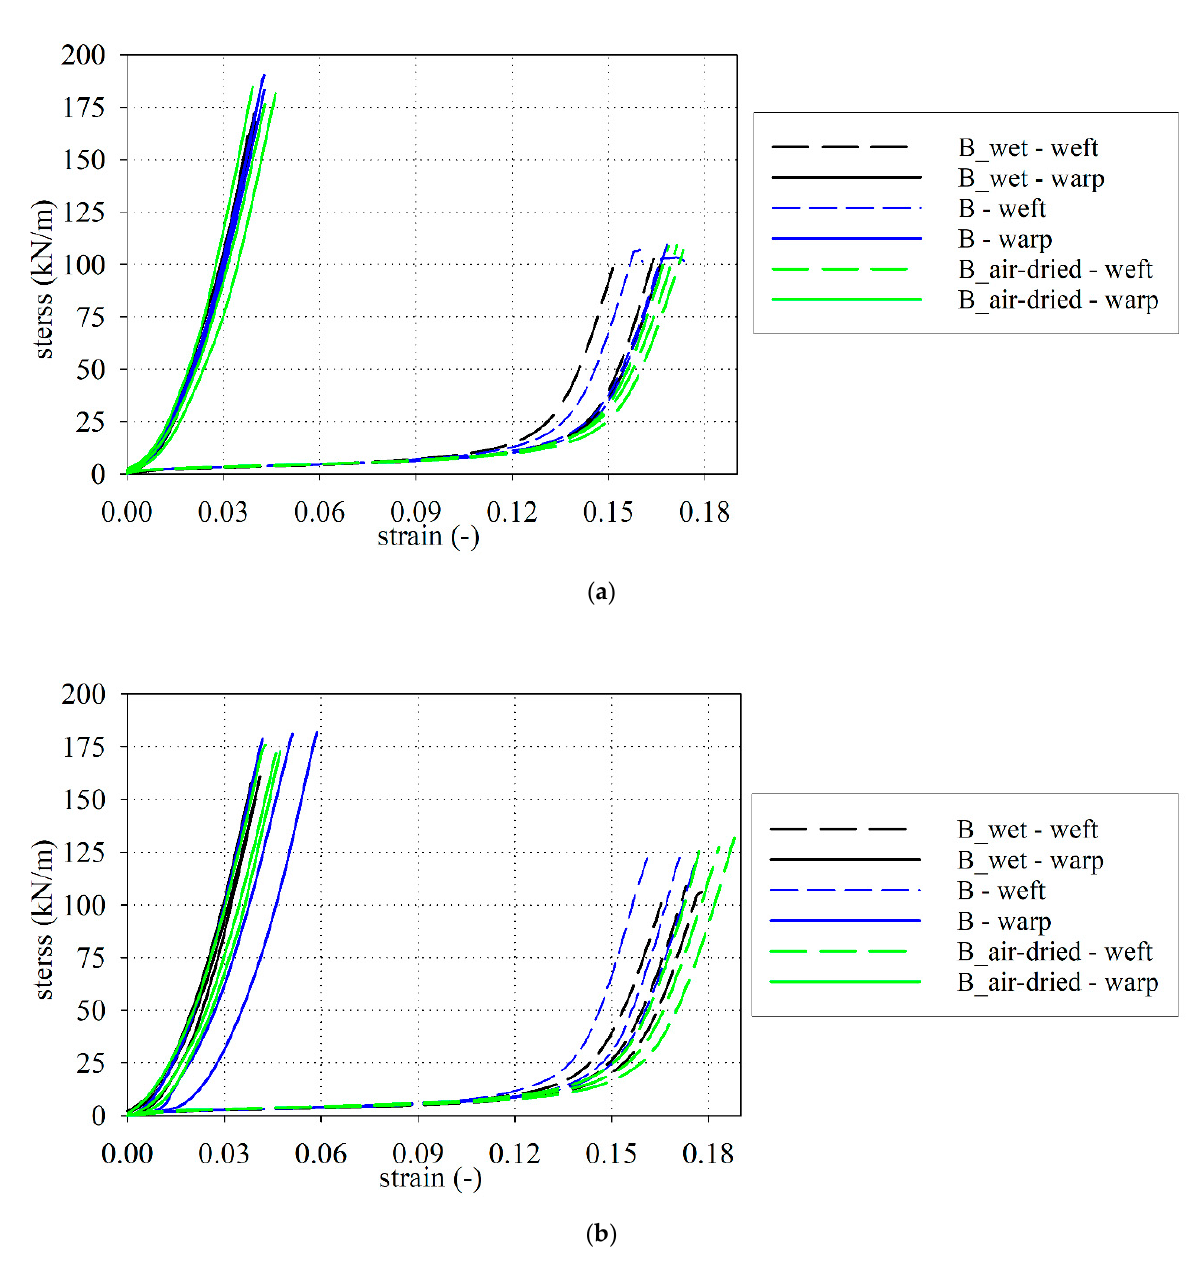
Figure 4. Stress-strain curves, B type fabric: ( a ) flat grips; ( b ) curved grips.